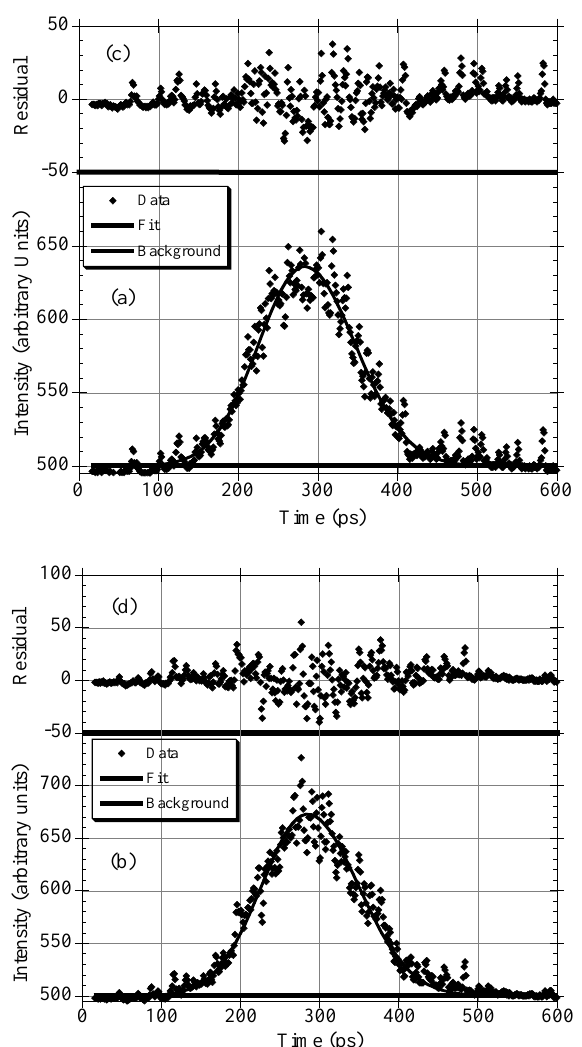
FIG. 26. A single data acquisition of the electron longitudinal bunch distribution measured by the streak camera when (a) the longitudinal feedback is off and the longitudinal instability is present and (b) the longitudinal feedback is on and the longi- tudinal instability is not present. The residual from the fit is plotted when the instability was present (c) and not present (d) longitudinal bunch distribution taken with the feedback